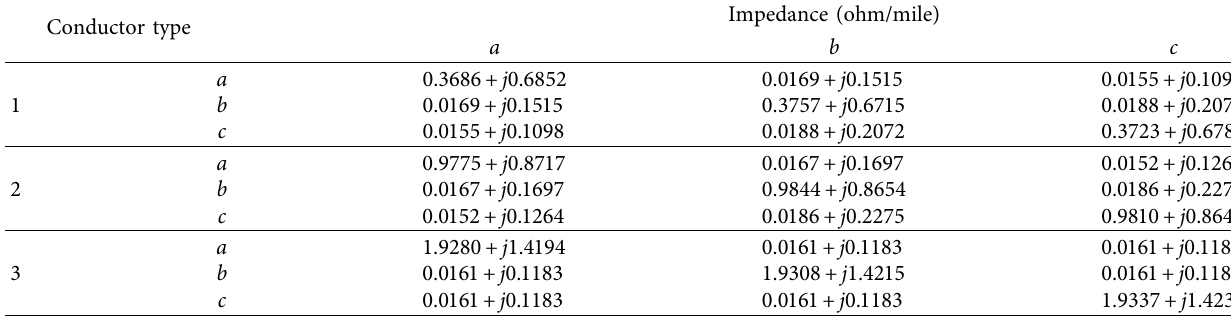
Table 4: Line impedance of 25-bus